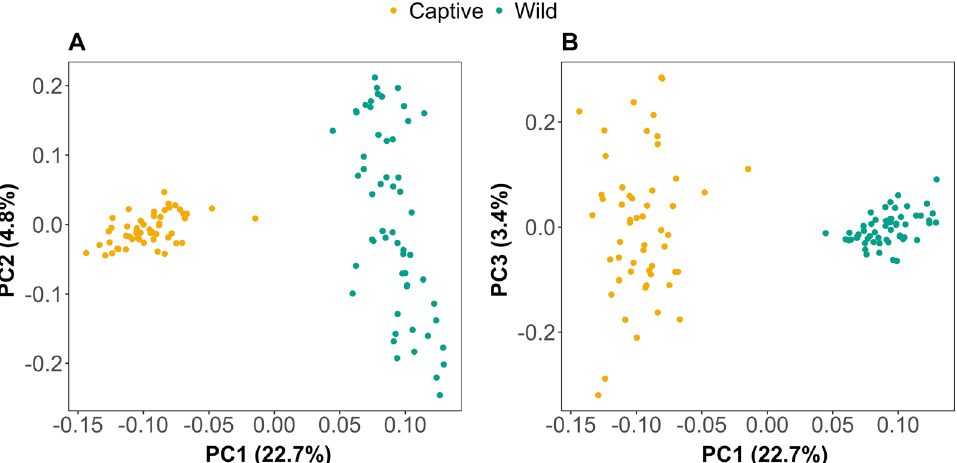
Fig. 1 Between-sample dissimilarity of fecal samples from captive and wild-caught Damaraland mole-rats based on Euclidean distances. A First and second principal component (PC1 & PC2), and B first and third principal component (PC1 & PC3). Each point represents a sample (N captive N wild 56) and are coloured according to origin of the sample (yellow =